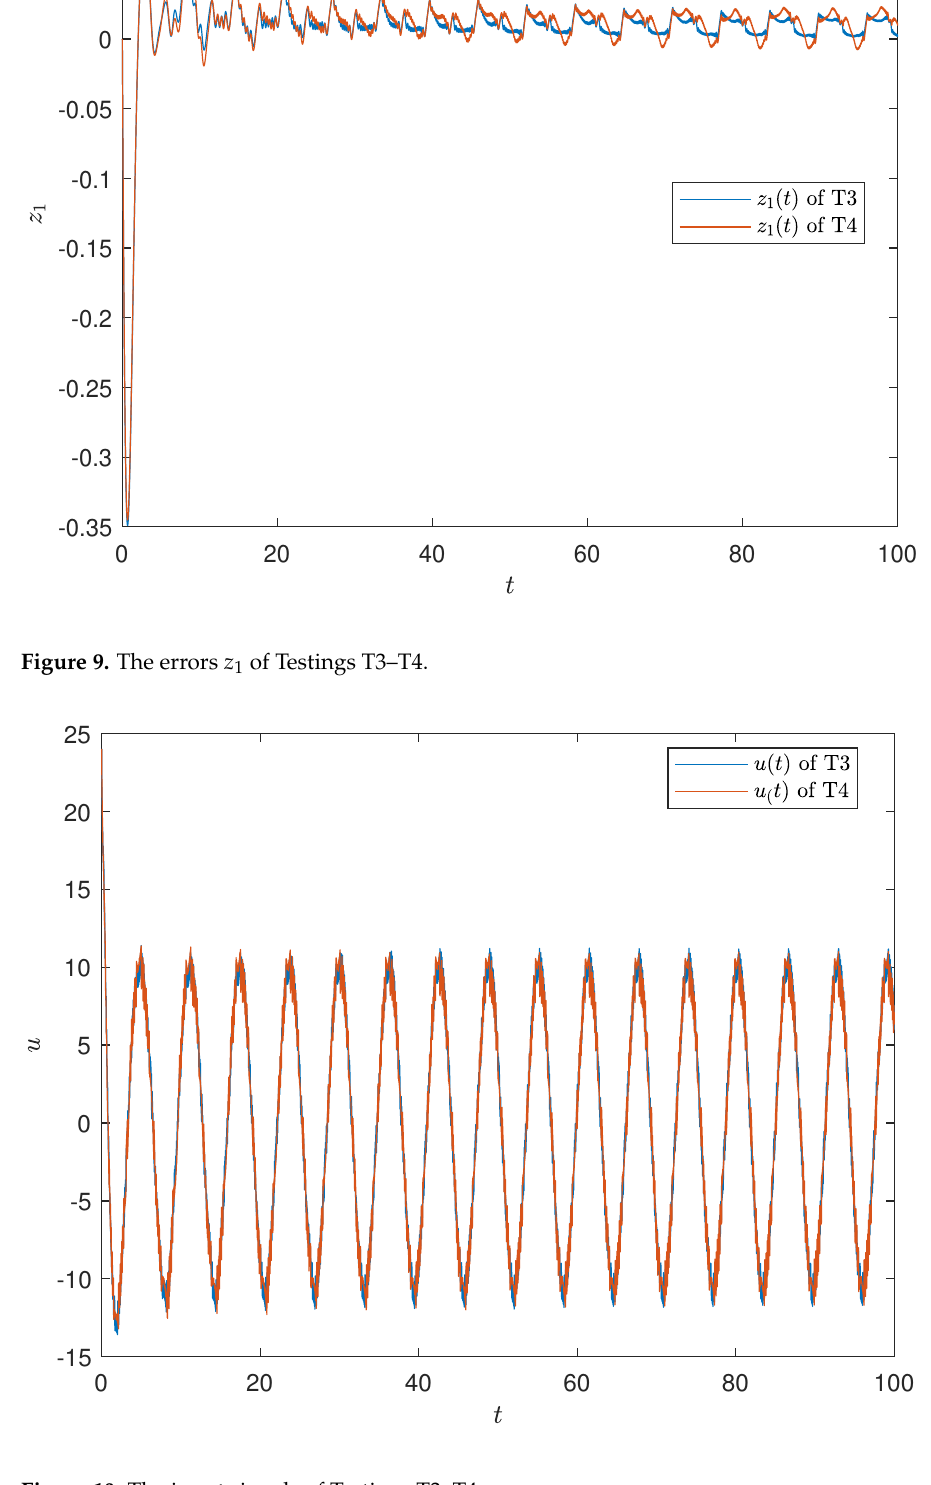
Figure 10. The input signals of Testings